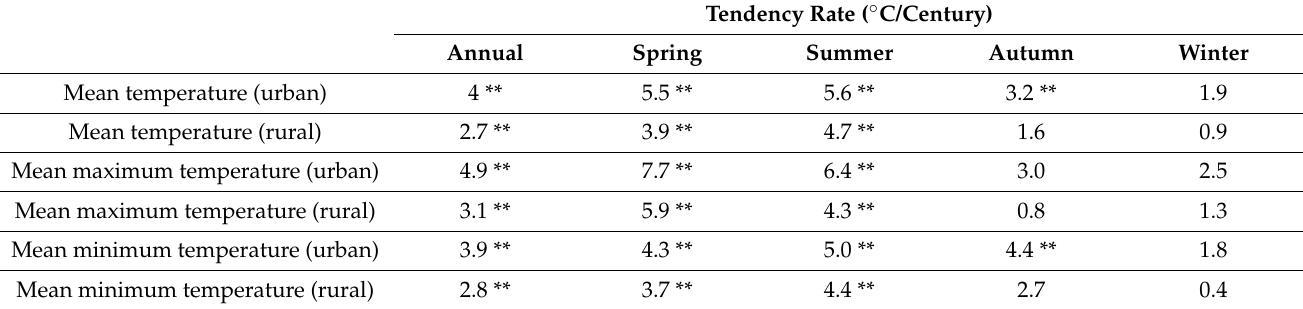
Table 2. The tendency rate of mean temperature, mean maximum and minimum temperature for urban and rural areas, 1985–2018.